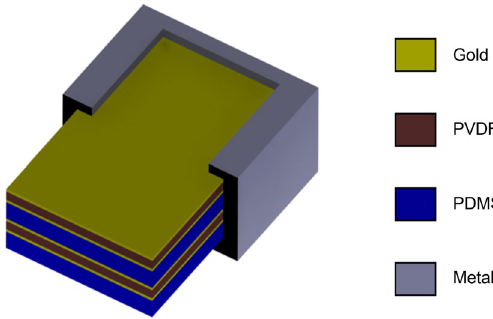
Figure 3. Fabrication process.